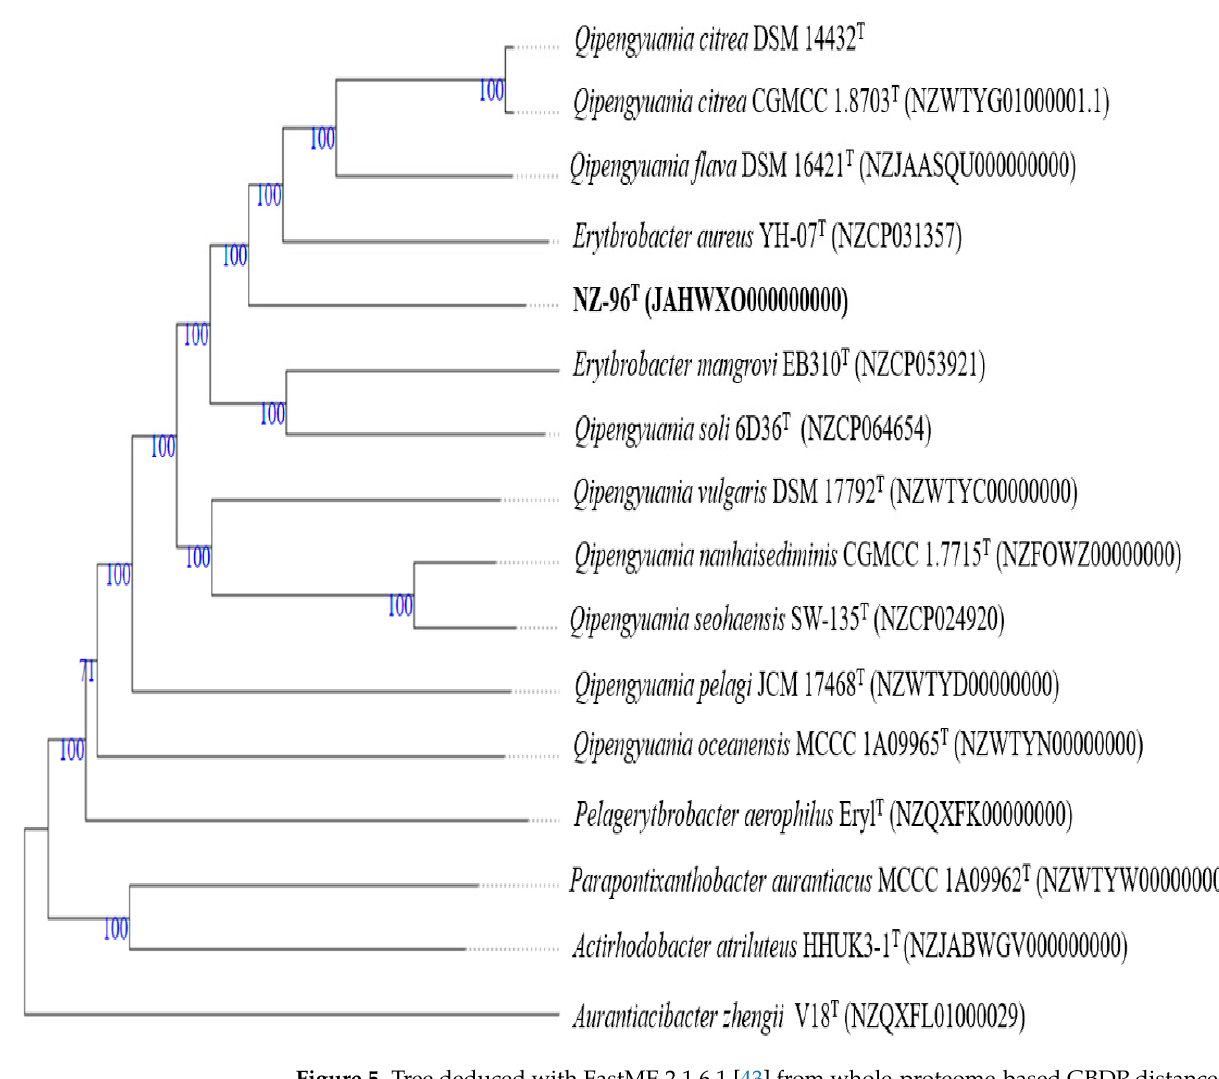
Figure 5. Tree deduced with FastME 2.1.6.1 [43] from whole-proteome-based GBDP distances. The branch lengths are scaled via GBDP distance formula d5. Branch values are GBDP pseudo-bootstrap support values >60% from 100 replications, with average branch support of 97.8%. Table 2. 16S, ANI, and dDDH values of NZ-96 T and its closely related phylogenetic species.